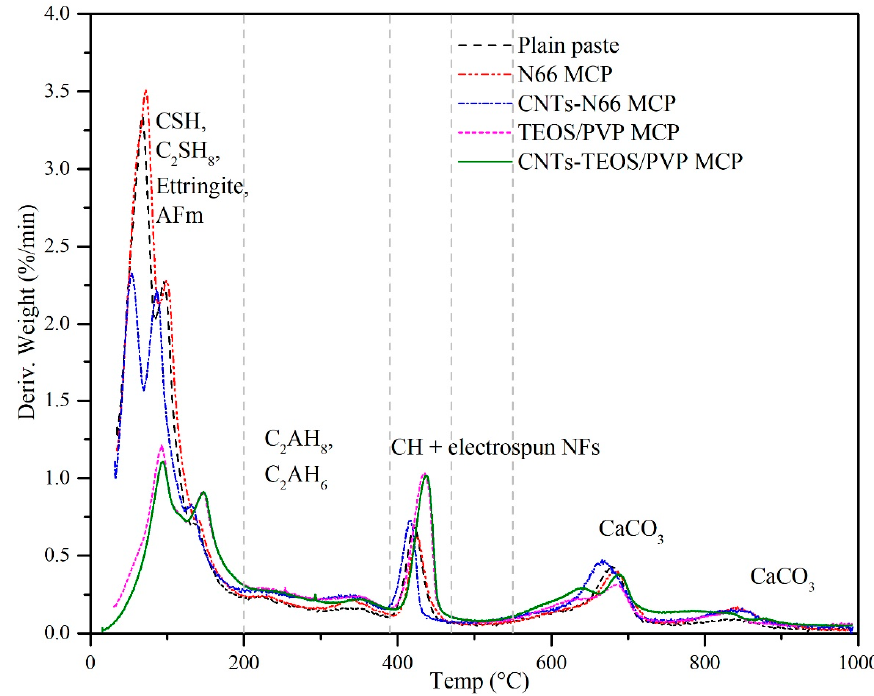
Figure 7. Derivative thermogravimetric ( DTG) curves of the hydrated cement pastes.